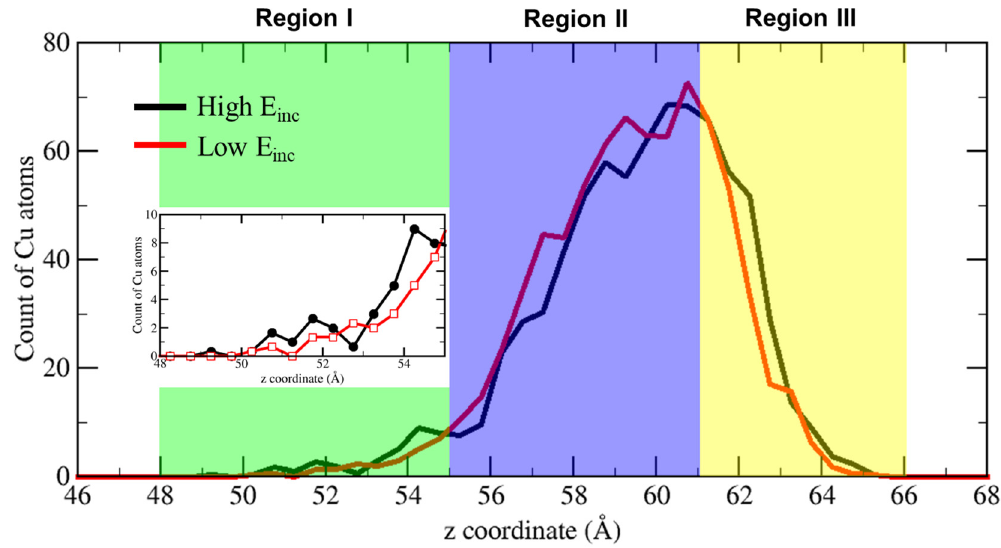
Figure 3. Comparison of IR on CAS substrate between ( a ) high E Inc and ( b ) low E Inc cases. Atom sizes of glass elements were reduced in the top view for emphasizing the adsorption of Cu atoms.